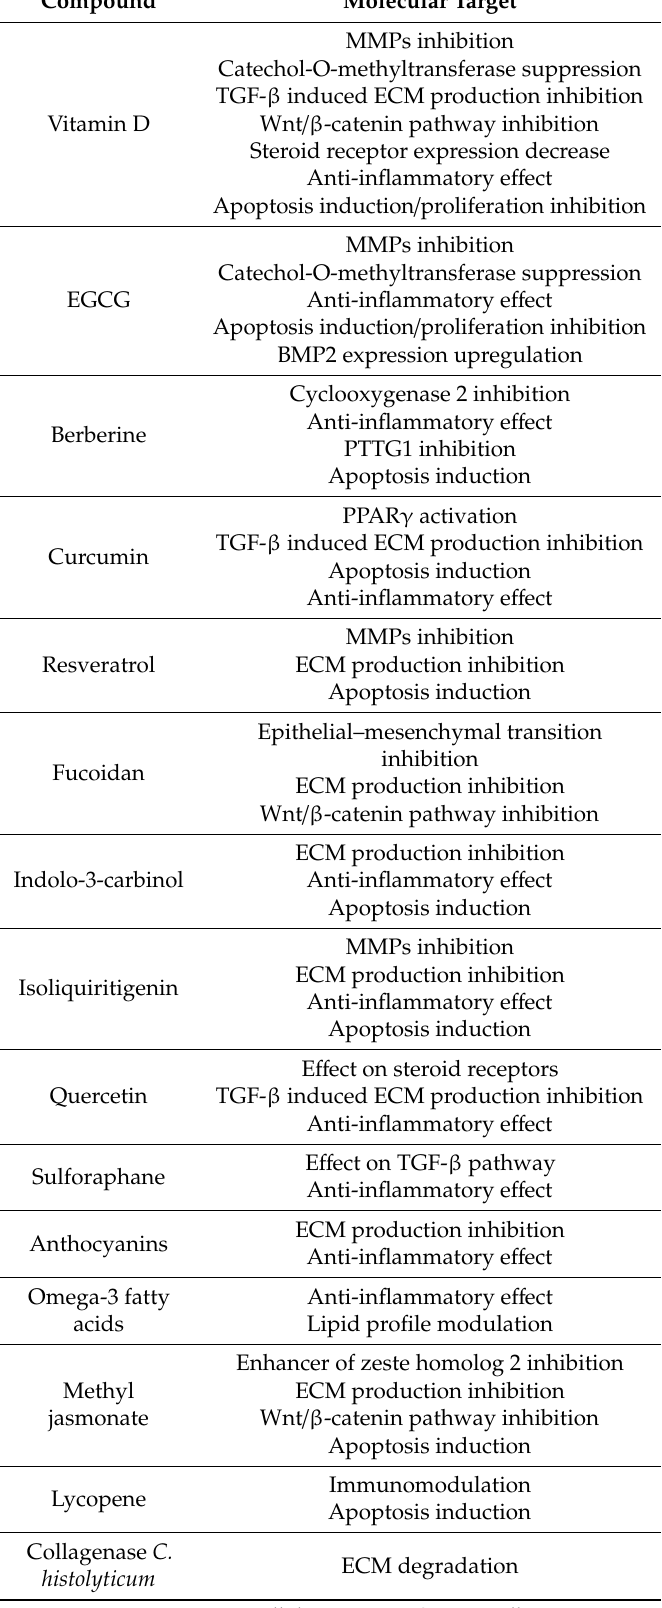
Bone morphogenetic protein 2–BMP2; extracellular matrix–ECM; metalloproteinases–MMPs; peroxisome proliferator-activated receptor γ –PPAR γ ; pituitary tumor transforming gene 1 protein–PTTG1; transforming growth factor beta–TGF- β ; wingless-type signaling